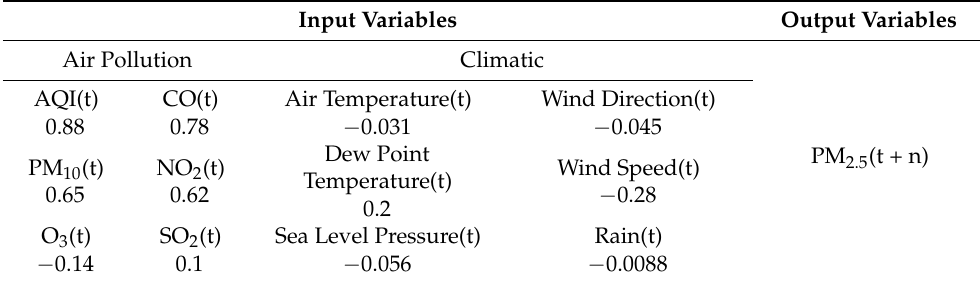
Table 2. Correlation analysis between PM 2.5 concentrations and other variables at all